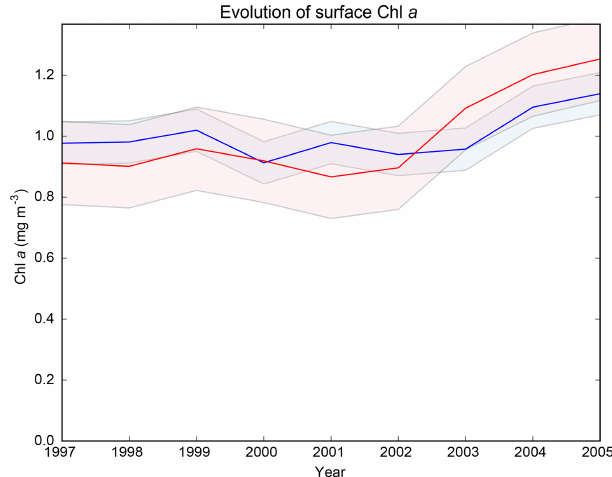
Figure 2. Average surface Chl a concentration from the HIS/A2 simulation in blue and from the SeaWiFS satellite data (Bosc et al., 2004) in red over the period 1997–2005. Shaded colors represent the standard deviations. Values are normalized by dividing by the average chlorophyll concentration over the